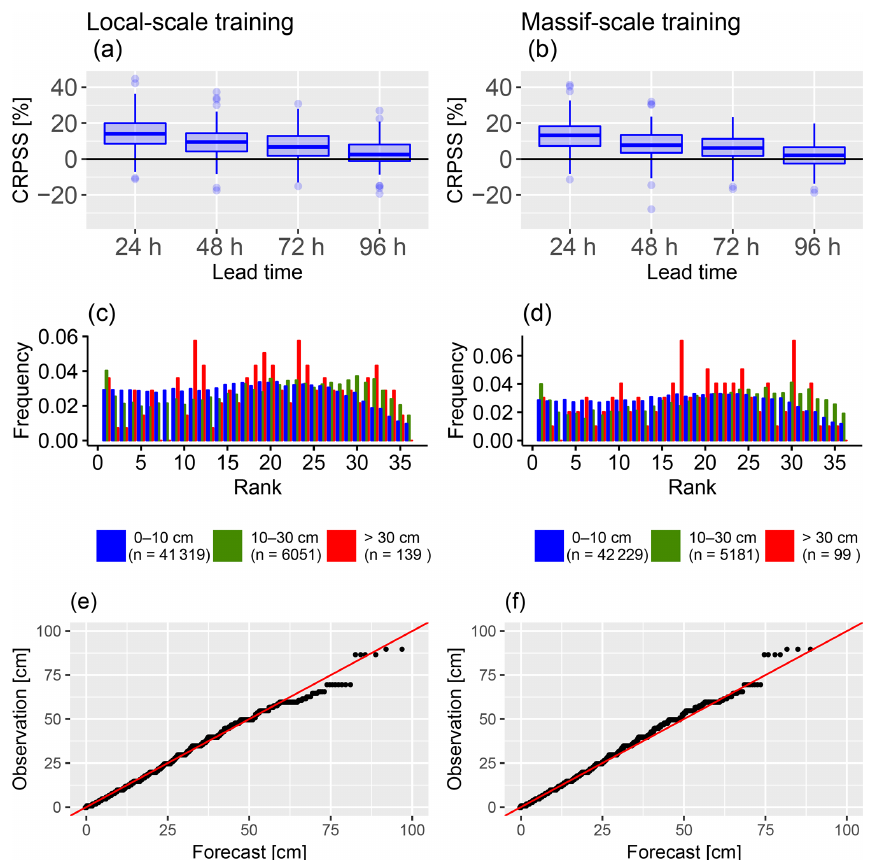
Figure 4. Comparison of post-processing skill between local-scale training (left column) and massif-scale training (right column) for post- processed HN forecasts calibrated with the reforecast dataset (1994–2016) and evaluated during winter 2017–2018. (a, b) CRPS of HN (cm) as a function of prediction lead time; the boxplot represents the variability of scores between the 113 stations. (c, d) Rank histograms; the three HN classes are the same as in Fig. 3b. (e, f) Quantile–quantile